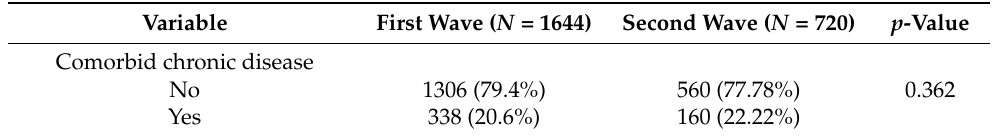
Table A2. COVID-19 related study group characteristics during the first and second wave of the COVID-19